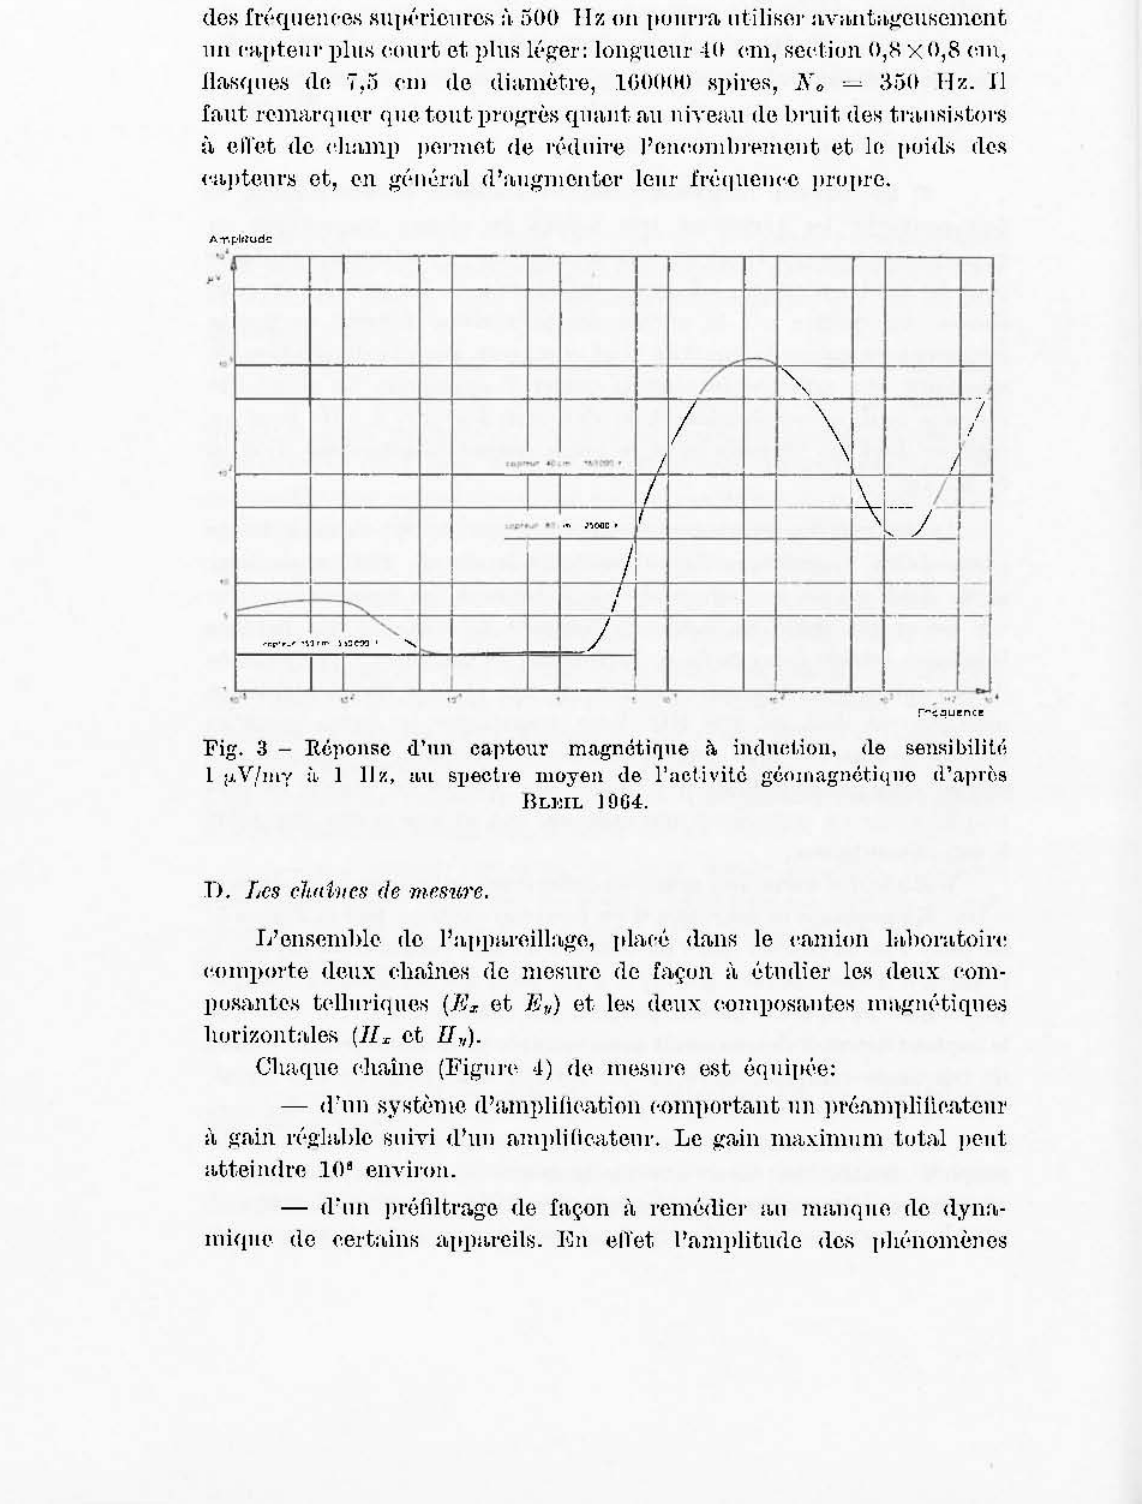
• ~, -,~. Fig. 3 - Ré)lOme d'un Mpteur magnéti!Jue il. indndioll, de sen~ibilit(i l i~V/Ill'( il. l Ilr., an SlJOOLl'e Illoyen de l'activit6 géoHlagllétiquc